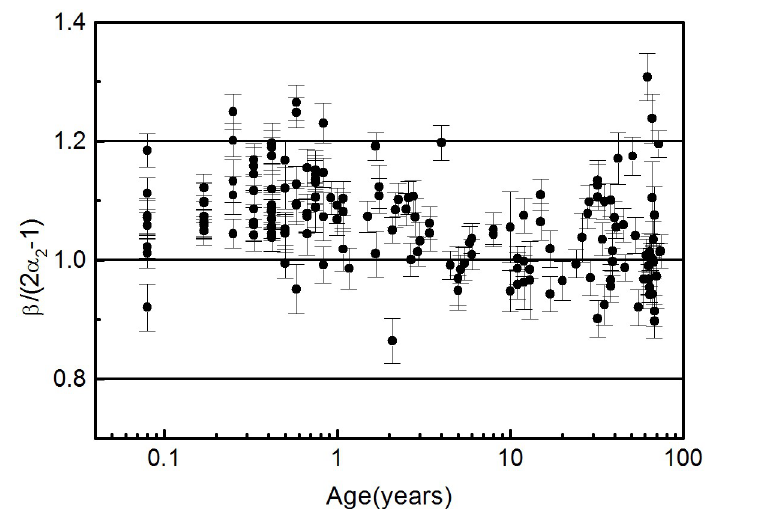
Fig 4. q ¼ b dependence on 2 a 2 (cid:0) 1